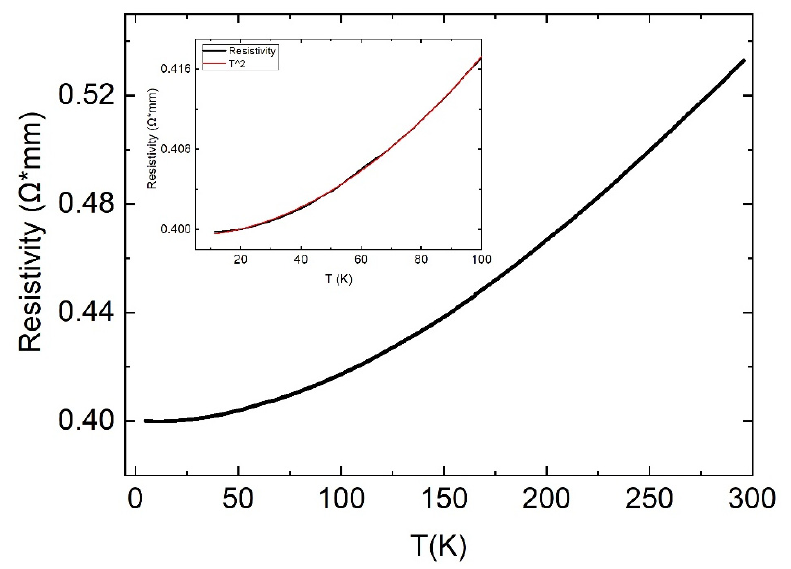
Figure 6. Electrical resistivity of Ca 1 − x Ir 4 S 8 . The inset shows the low-temperature data which can be well fitted with a quadratic power law, as is typical for metallic